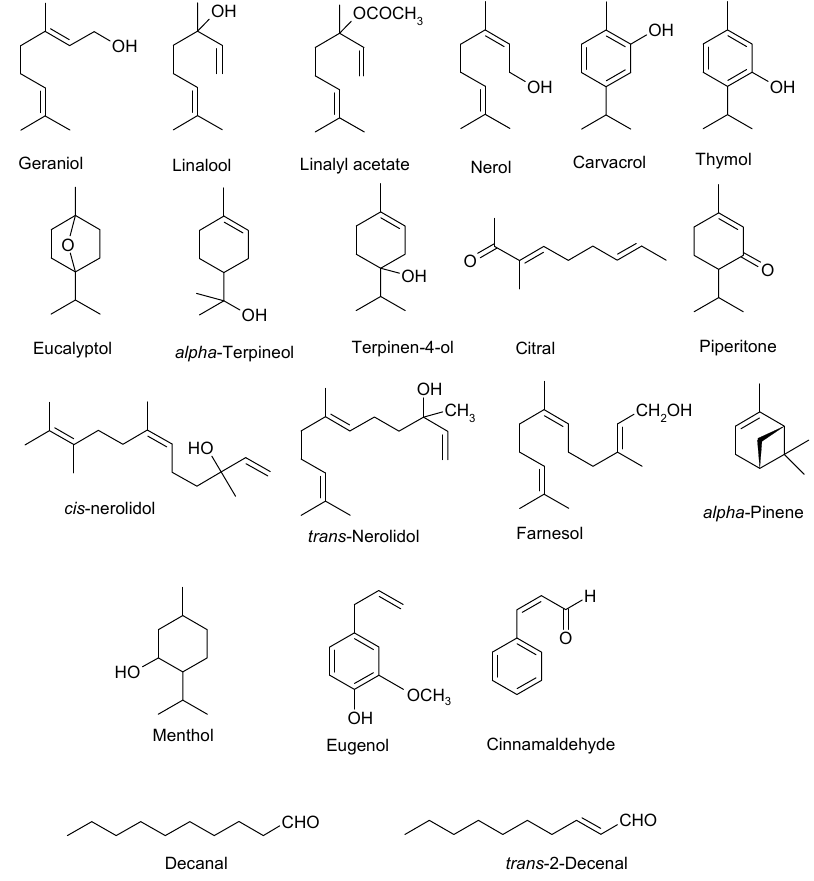
Figure 1. The main components of essential oils (EOs).